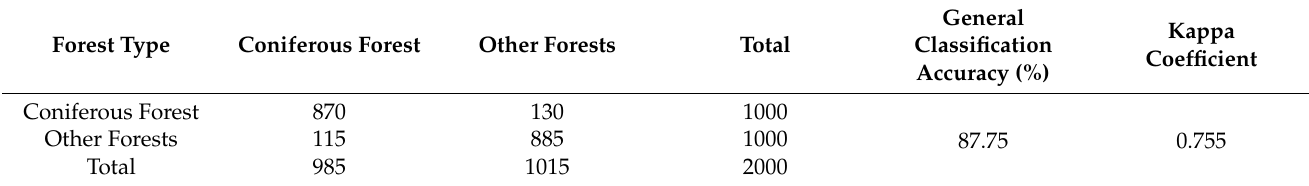
Table 4. Accuracy evaluation of classification results.